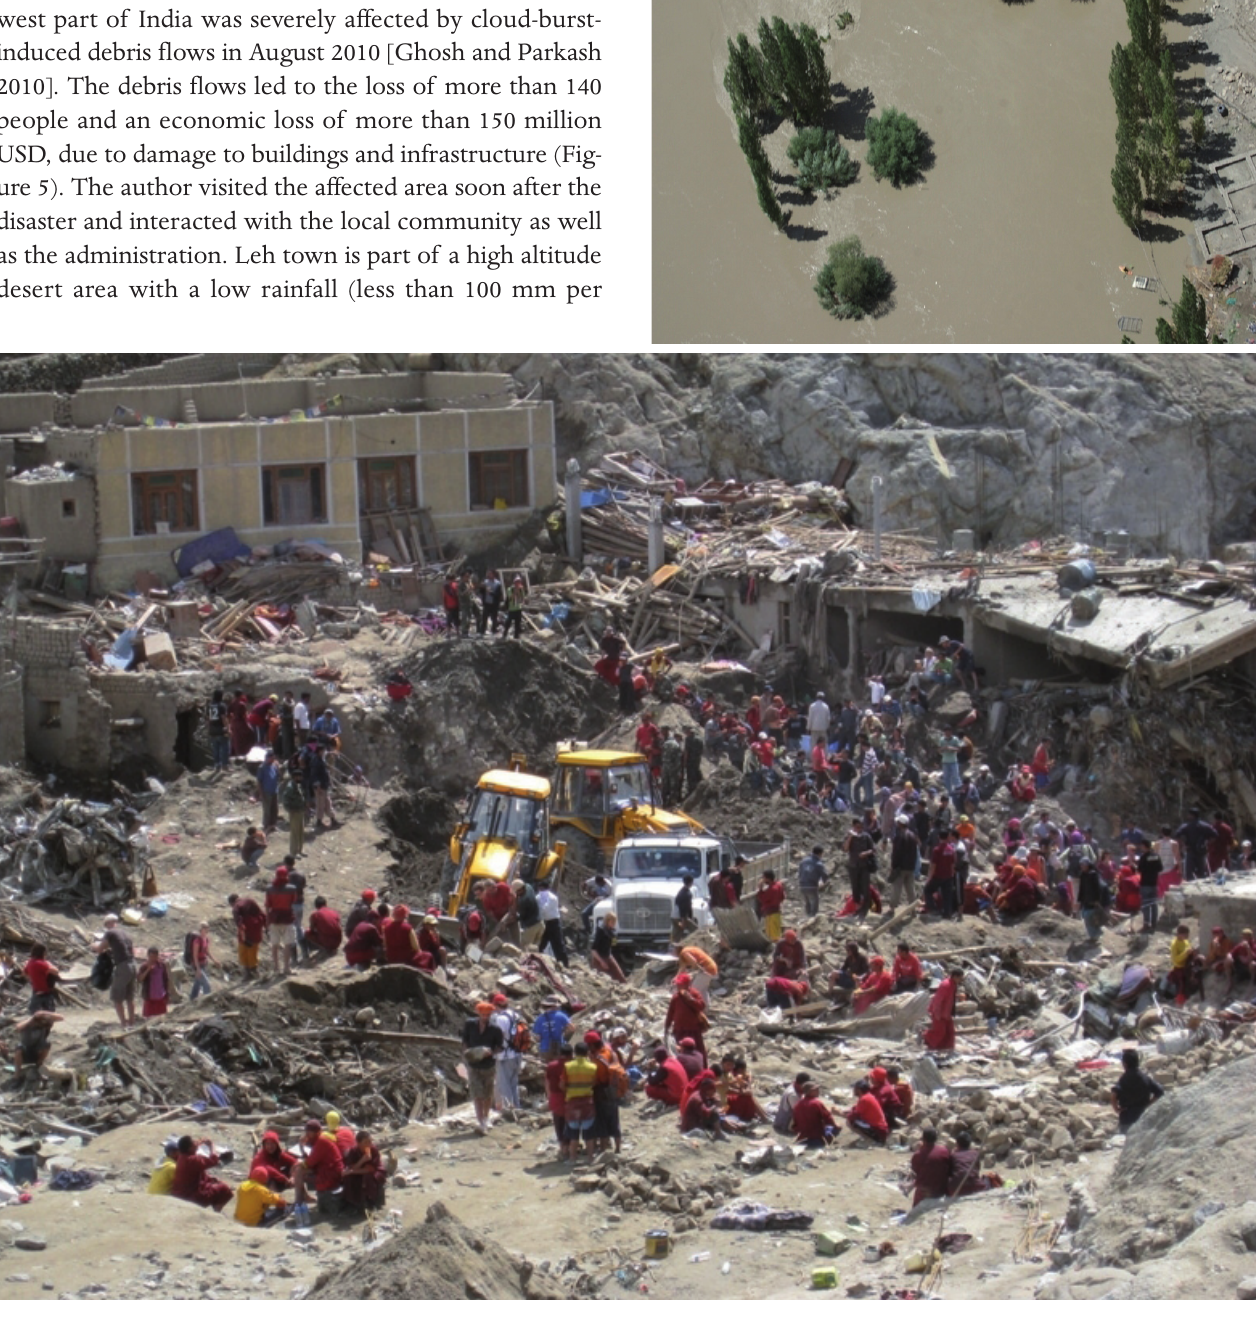
Figure 5 (top right). Flash floods and debris flow at Leh submerged and damaged buildings and infrastructure after heavy precipitation during August 2010. Figure 6 (bottom). Impact of debris flow and response of victims in Leh during the August 2010